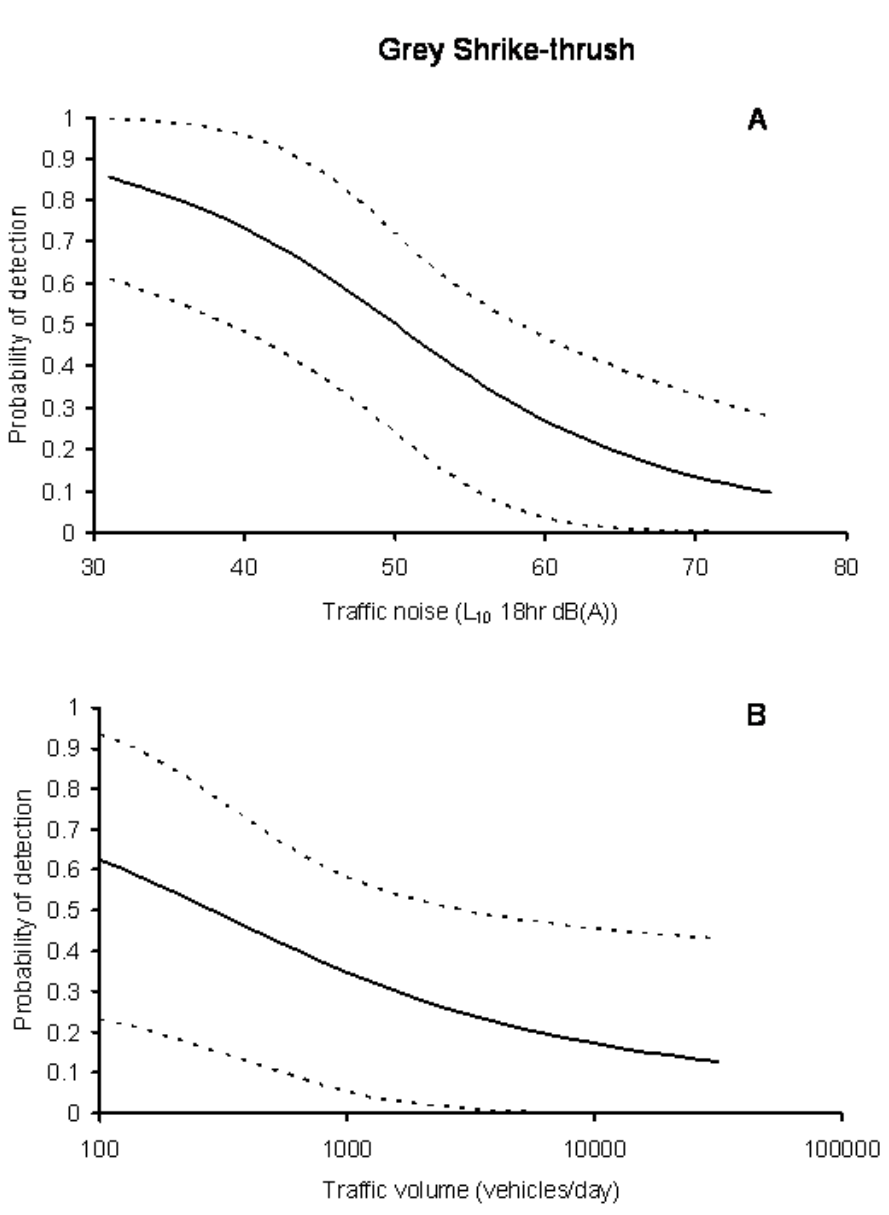
Fig. 4. Predicted probability of detecting the Grey Shrike-thrush on a visit to a site as a function of (A) traffic noise and (B) traffic volume, across all 58 sites. Solid lines show the predicted relationships and dashed lines indicate the 95% credible